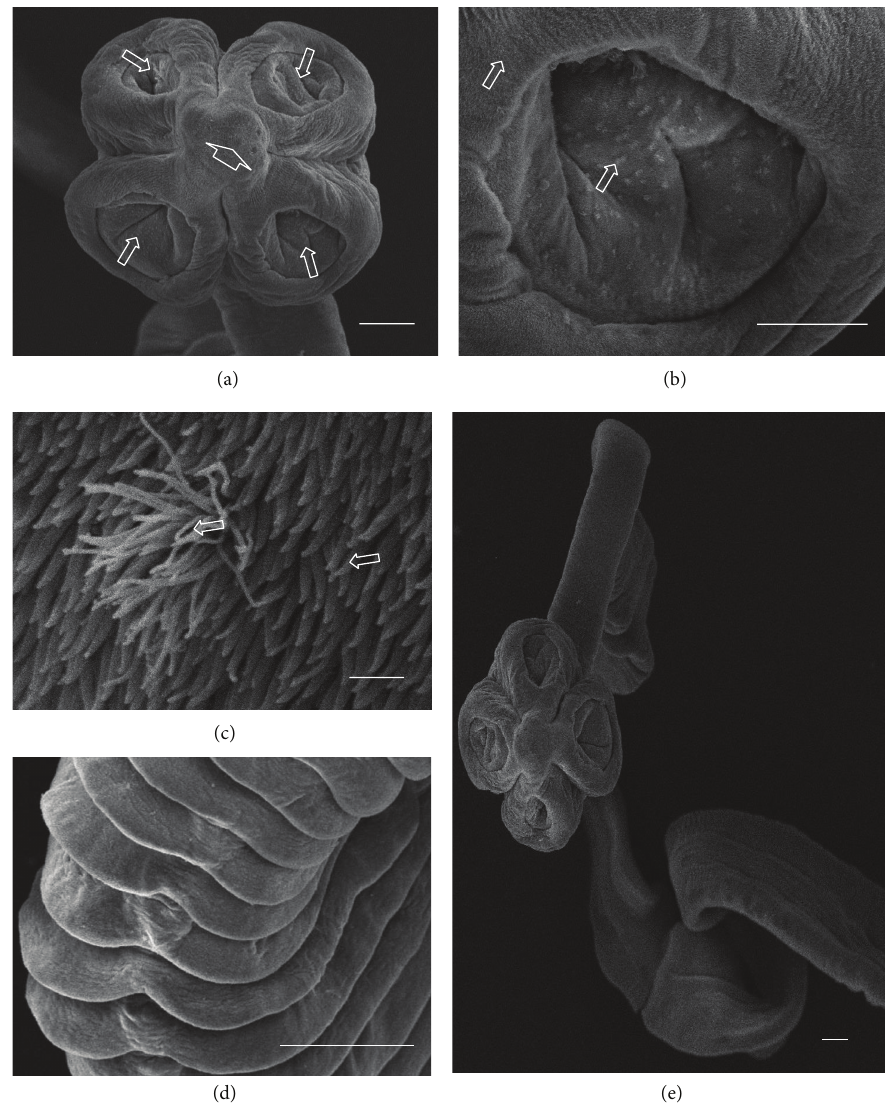
Figure5:(a)–(e)Scanningelectronmicrographsof Stilesiaglobipunctata .(a)Generalanteriorviewofscolex,arrowsshowinvaginatedsuckers and arrowhead shows apical part. (b) Invaginated sucker, arrows show acicular and capilliform filitriches (scale bar, 50 𝜇 m). (c) Acicular and capilliform filitriches covering sucker (scale bar, 1 𝜇 m). (d) Portion of S. globipunctata showing spiral strobila. (e) Portion of strobila showing craspedote proglottids. Scale bar = 100 𝜇 m, unless stated